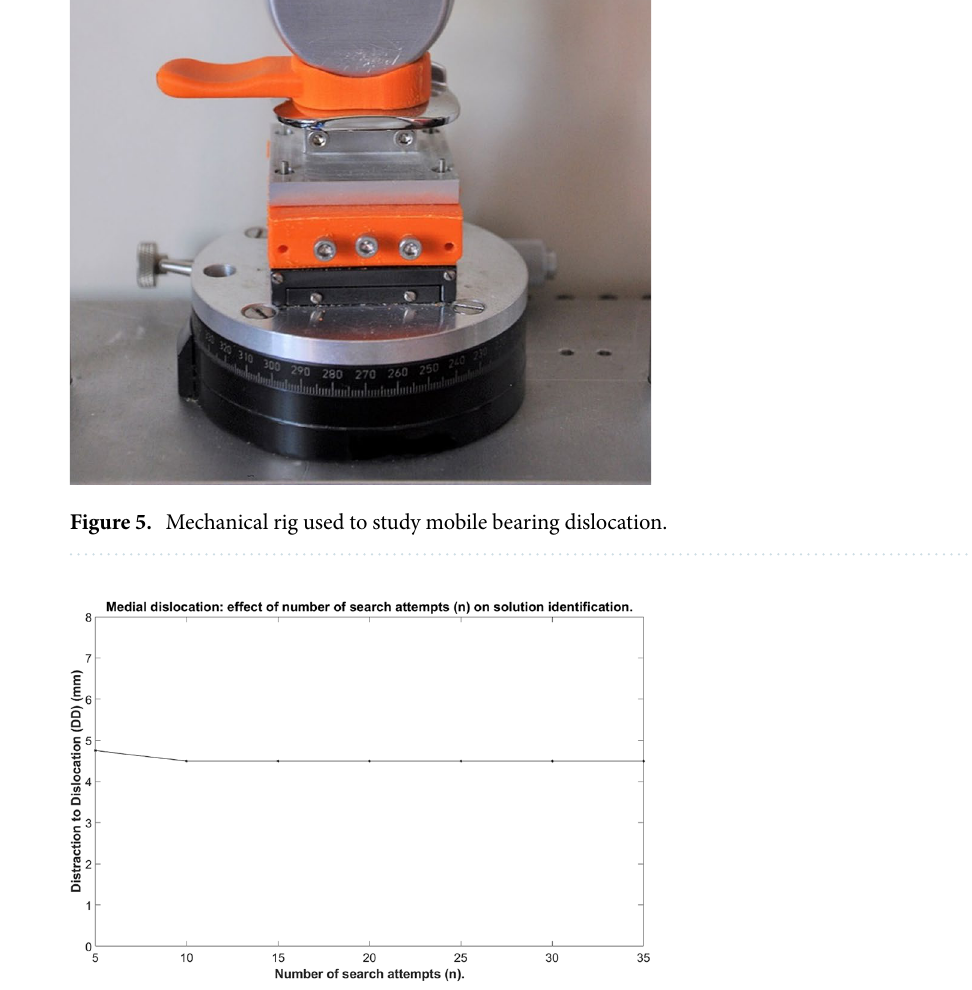
Figure 6. The effect of number of searches (n) on solution